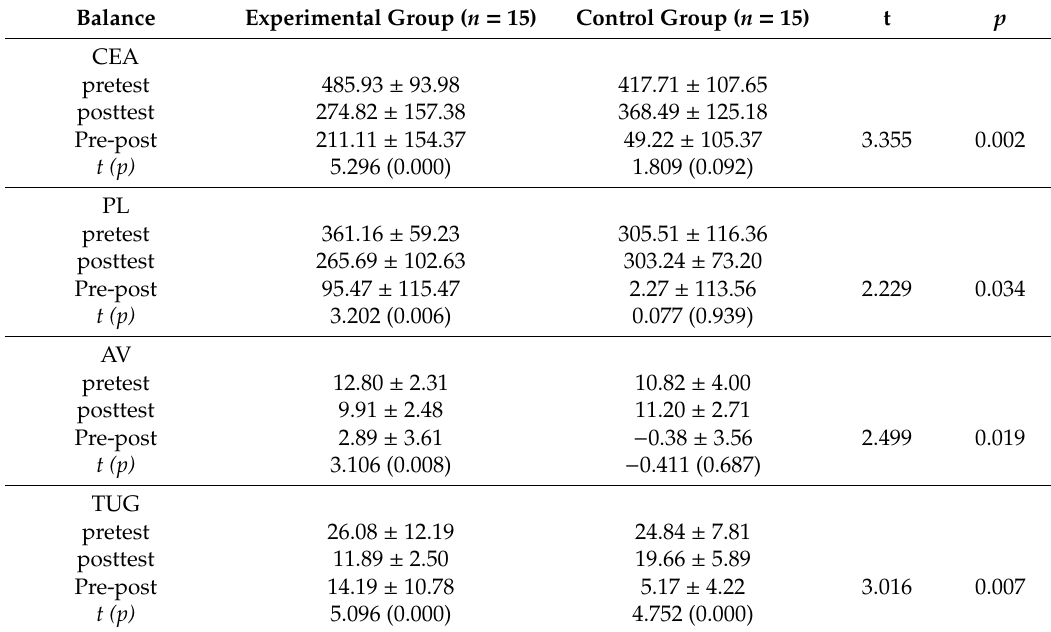
Table 5. Comparison of balance test ( n =